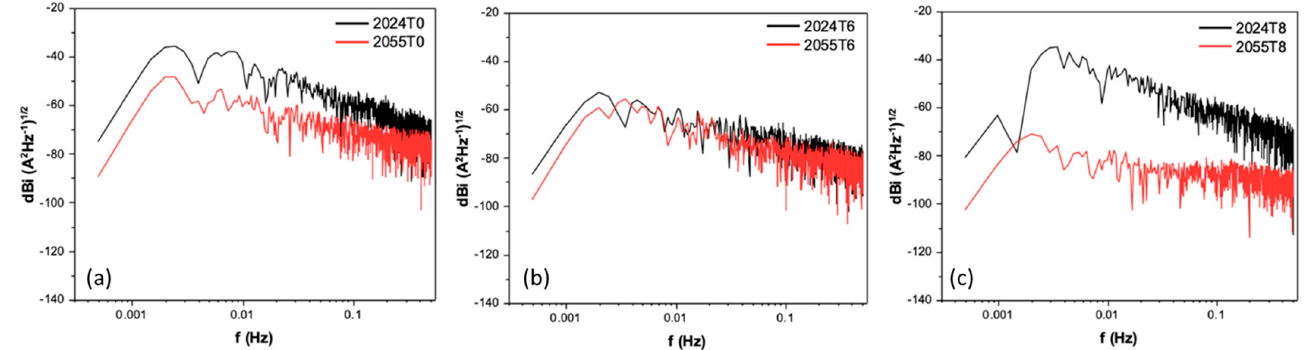
Figure 9. Power spectral density (PSD), in current, for aluminum alloys under ( a ) T0, ( b ) T6, and ( c ) T8 heat treatment conditions, exposed to a 3.5 wt. % NaCl solution. Table 5. Electrochemical noise parameters for aluminum alloys under heat treatment conditions and exposed to 3.5 wt. % NaCl, 1 wt. % HCl, and 1 wt. % H 2 SO 4 solutions.